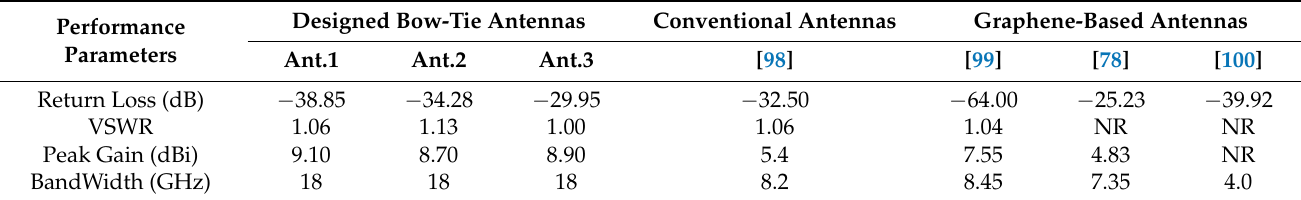
Table 4. Performance comparison of previous studies and graphene-based bow-tie antennas designed in this study.